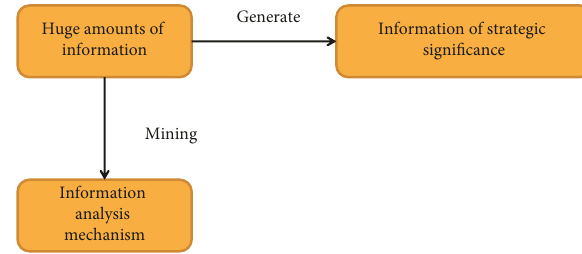
Figure 7: Functional diagram of information analysis mechanism.